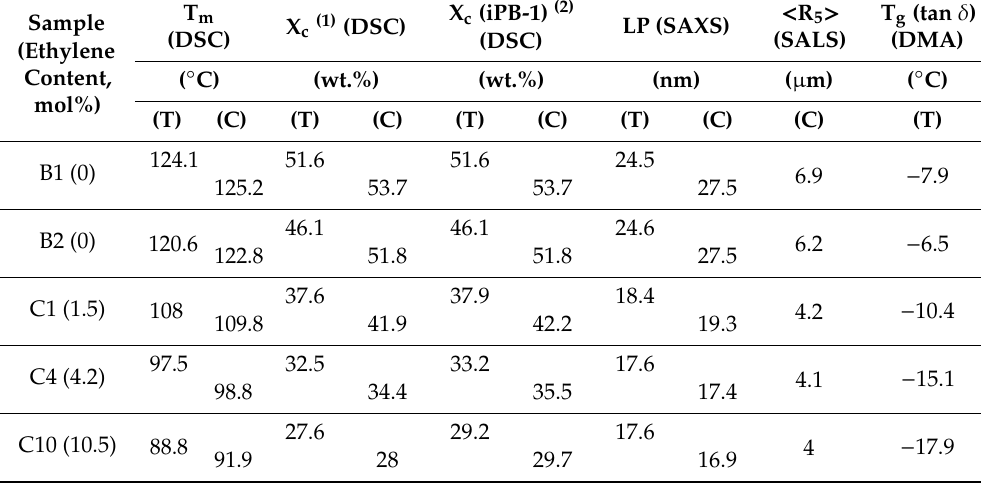
Table 2. Structural parameters of samples studied: The melting temperature, T m ; overall crystallinity, X c ; crystallinity of the iPB-1 fraction, X c (iPB-1); long period, LP; average spherulite size, < R 5 > ; and glass transition temperature, T g (represented by the loss tangent, tan δ